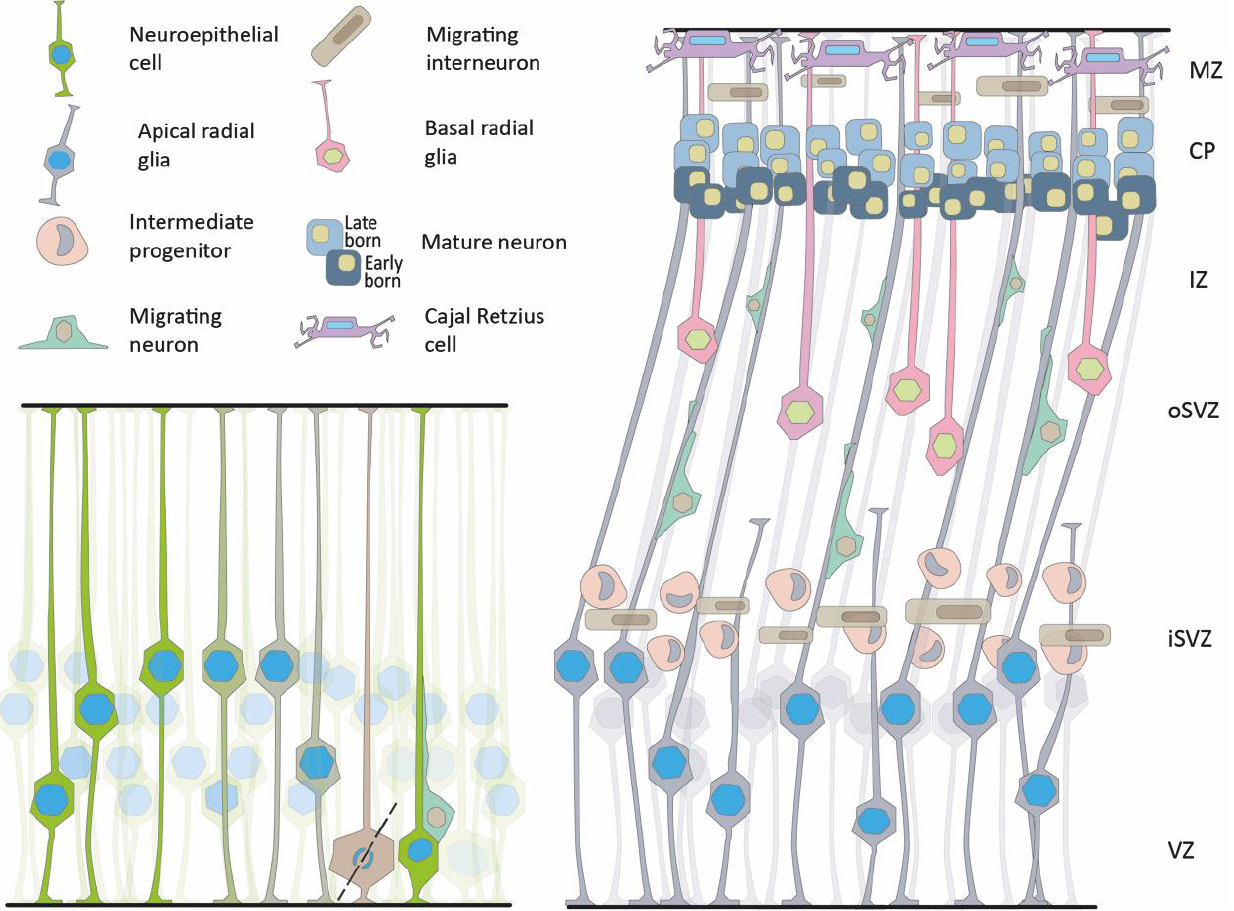
Figure 2. The neuroepithelium and neuronal migration. Left, schematic presentation of the early neuroepithelium, showing interkinetic nuclear motility and asymmetric cell division leading to the formation of two daughter cells, a progenitor and a migrating neuron. Right, Later stages of brain development show three proliferative areas, the ventricular zone (VZ), the inner subventricular zone (iSVZ), and the outer subventricular zone (oSVZ). Different types of progenitors can be detected in the proliferative zones, radial glia, intermediate progenitors, and basal radial glia. Migrating neurons can be seen in the intermediate zone (IZ). The pyramidal neurons are organized in layers in the forming cortical plate (CP) based on their birth date. Cajal–Retzius cells that are born the earliest are detected in the marginal zone (MZ). Migrating interneurons are visible in two migratory streams.